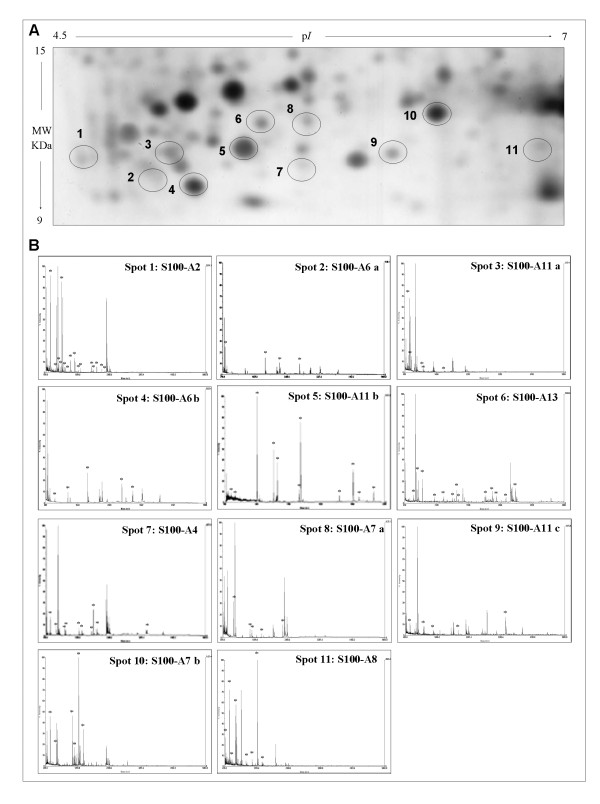
Identification of S100 proteins. A) Gel window comprising an area covering a pI/kDa range of 4.5-7/15-9 kDa, where the majority of known members of non-keratin associated S100 proteins, are expected to localize. The protein spots localizing in this area were picked from the gels and digested with trypsin. The resulting fragments were analyzed by mass spectrometry. Eleven spots were identified as S100 protein members. The numbers indicate the eleven spots corresponding to S100 proteins, whose spectra are shown in B). The mass peaks marked with an asterisk match the theoretical spectrum of the assigned proteins.